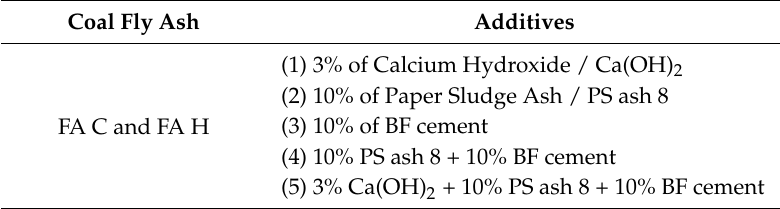
Figure 3. Schematic diagram of the sample preparation and leaching test. Table 2. Ratio of additives in coal fly ash